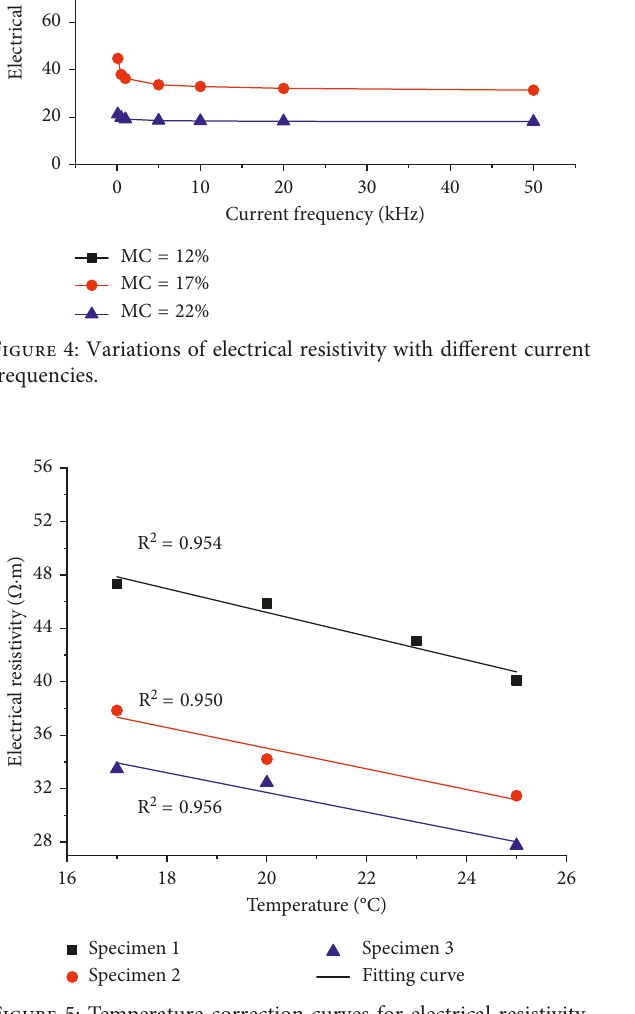
Figure 5: Temperature correction curves for electrical resistivity.